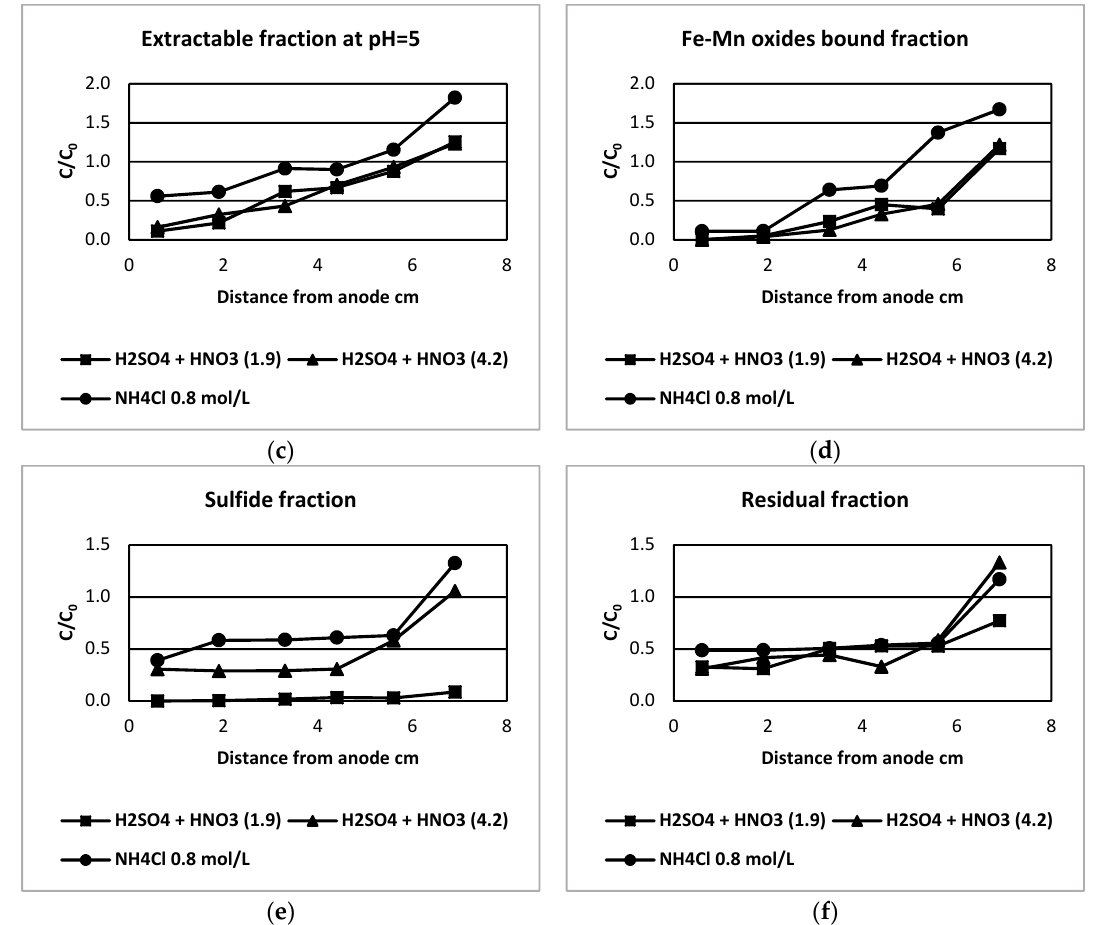
Figure 1. C/C 0 ratio of copper concentration for slices closest to anode and closest to cathode for different pre-treatment solutions after electrodialytic remediation. Analysis of the six-fraction procedure, where the fractions are: ( a ) water soluble fraction, ( b ) exchangeable fraction, ( c ) extractable fraction at pH = 5, ( d ) Fe-Mn oxides bound fraction, ( e ) sulfide fraction and ( f ) residual fraction.